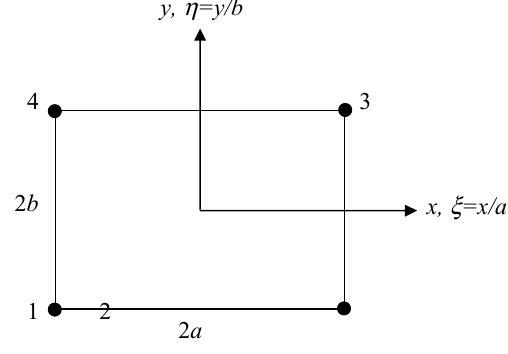
Fig. 2. A 4-noded, 12 degrees of freedom PBQ4 Mindlin plate